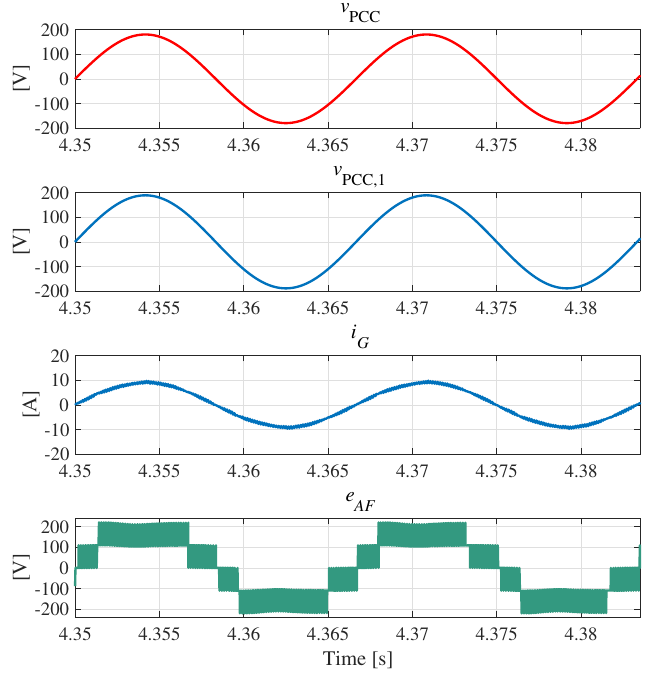
Figure 6. Steady state responses of the grid voltage v PCC , the fundamental component of the grid voltage v PCC,1 , the line current i G , and the multilevel output voltage of the inverter e AF